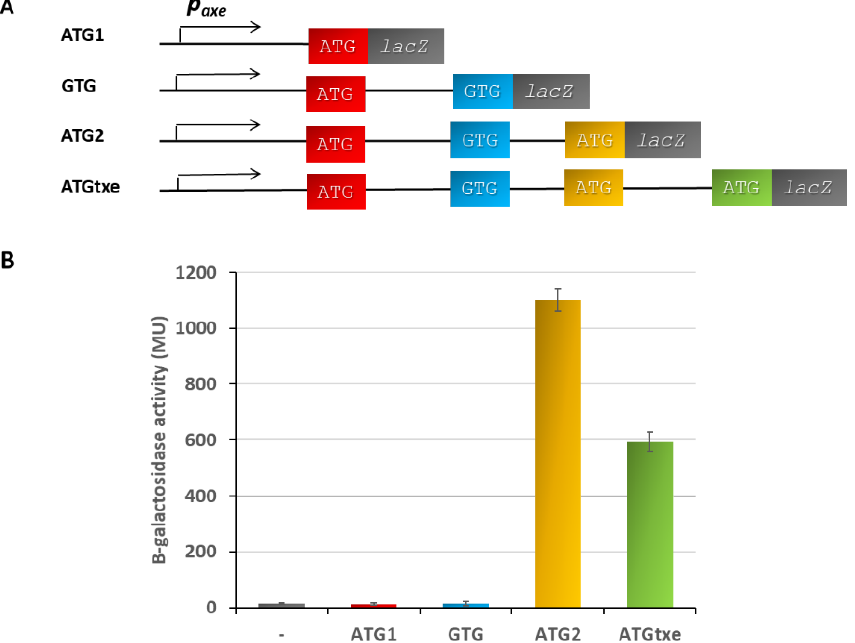
Figure 2. Translation ability of start codons from p axe leader. ( A ) Schematic organization of the translation fusions where successive ATG and GTG codons were fused in frame with the lacZ gene deprived of its own translation signals. ( B ) Appropriate pRW225 vector fusions were introduced into ∆ 5 ∆ lac E. coli strain, and β -galactosidase activity was assessed when cell cultures reached OD 600 ≈ 0.5. These results are the average of at least three independent experiments; error bars represent standard deviation (S.D.).